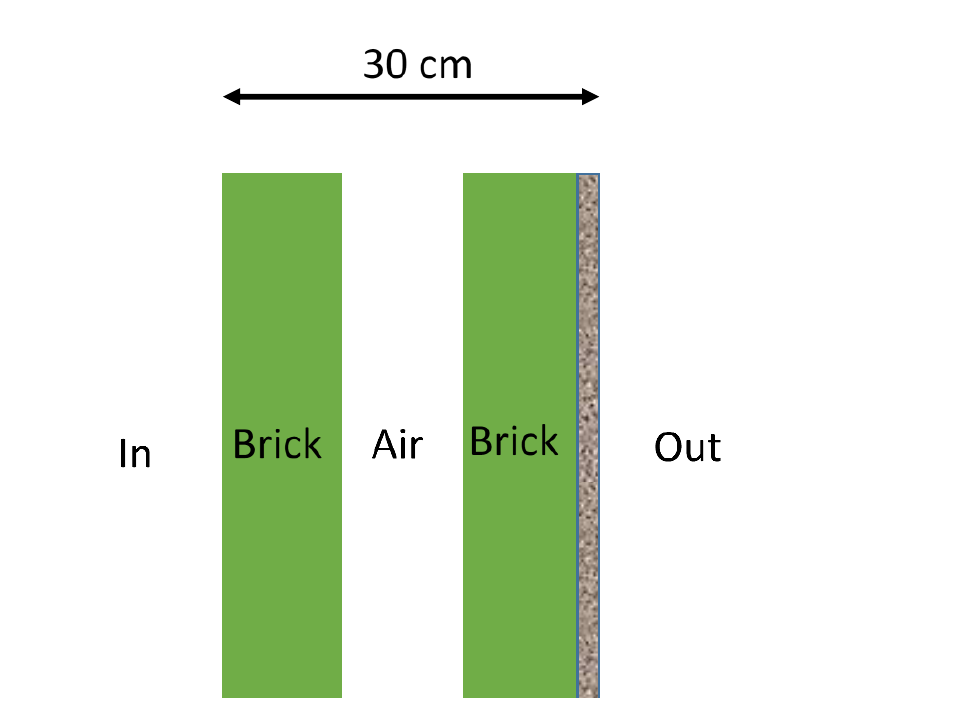
Figure 9. Building facade with no windows.